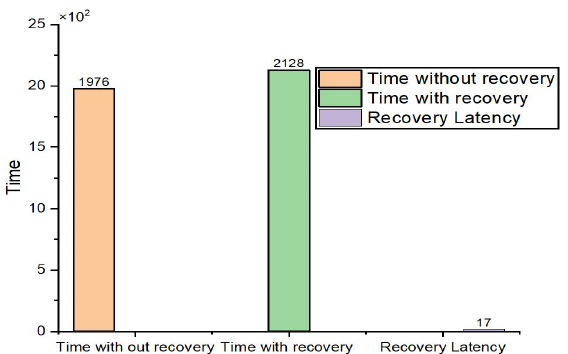
Figure 14. Results (time): for pattern